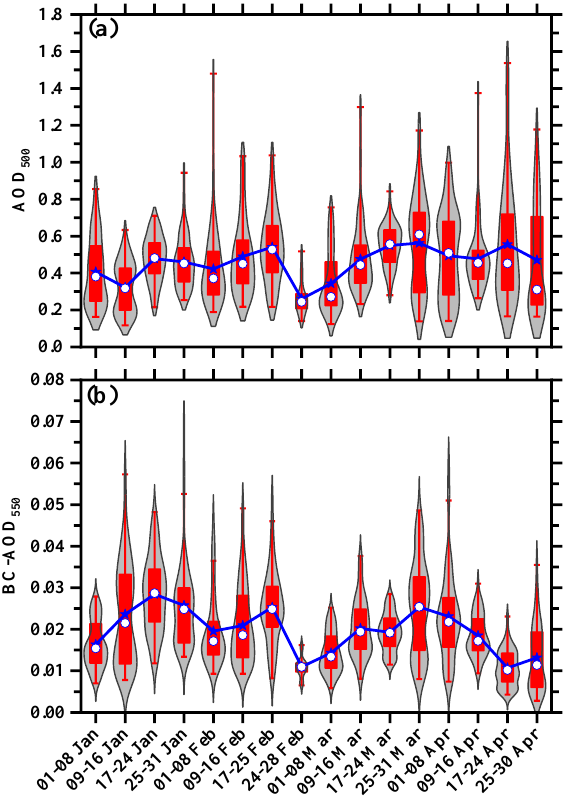
Figure 5. Weekly average of AOD ( a ) and BC AOD ( b ) at 550 nm.